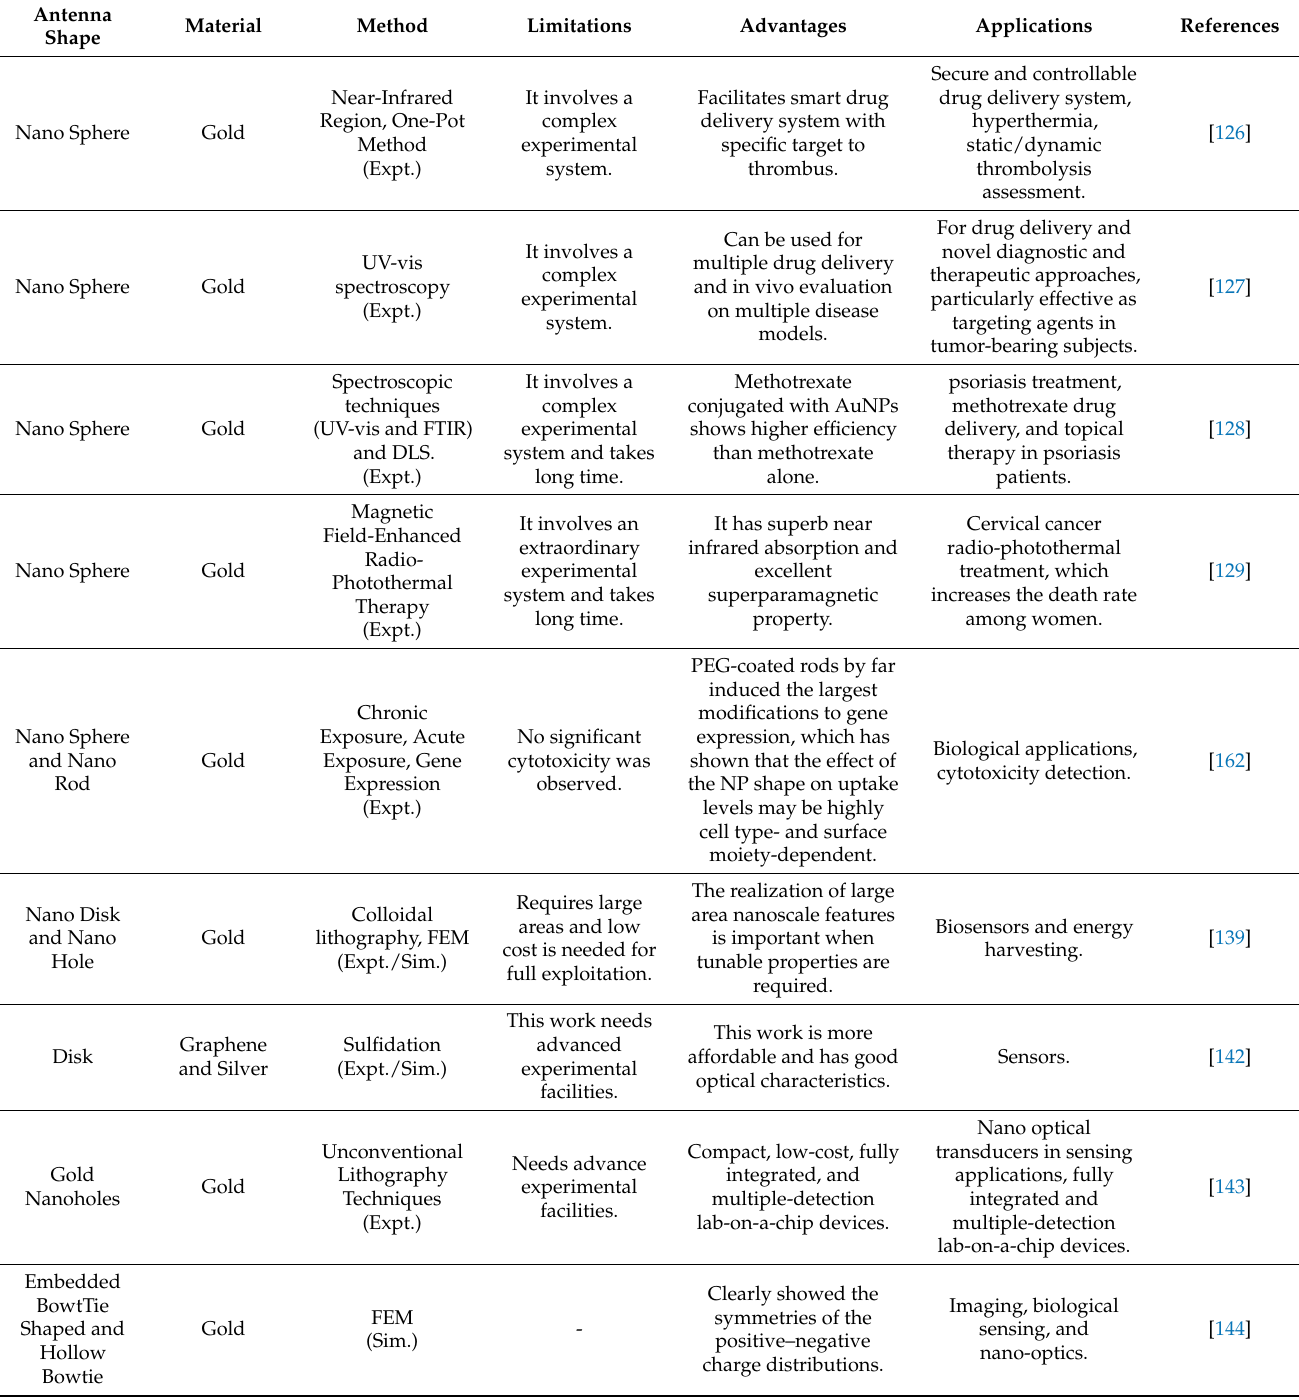
Table 1. A list of nanoparticles and their characteristics in biosensing